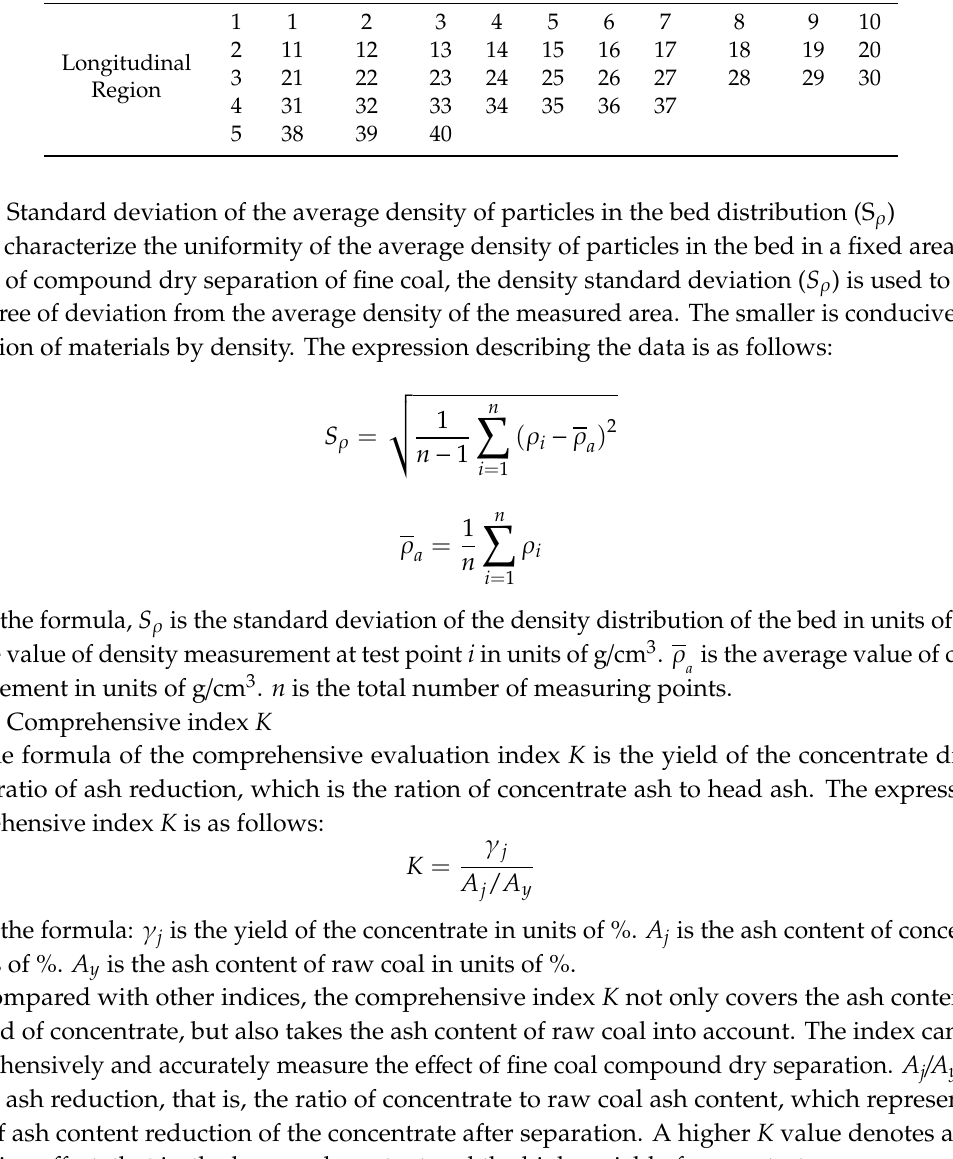
Table 3. Compound dry separation average density of particles in the bed test sampling layout table. Transverse Base Point